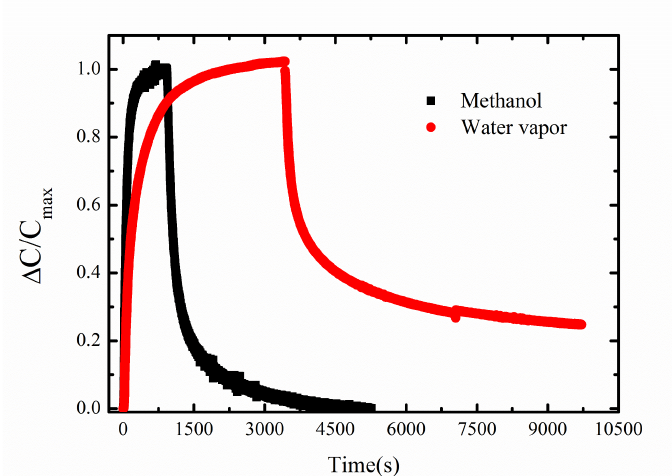
Figure 10. Methanol and water vapor sensing and recovery curves at 5000 ppm at 20 ◦ C.